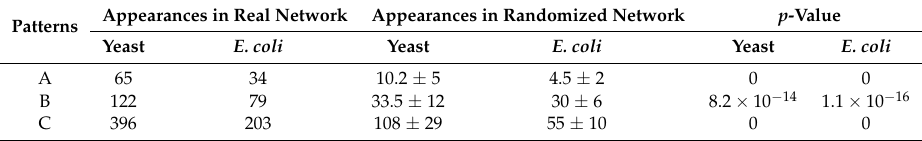
Table 1. Statistically significant patterns appearing in transcriptional regulation networks. Pattern A refers to a coherent feed-forward loop whose connections are x → y → z and x → z. Pattern B refers to these subgraphs with single input module (>10 nodes). Pattern C refers to pairs of operons controlled by the same two transcription